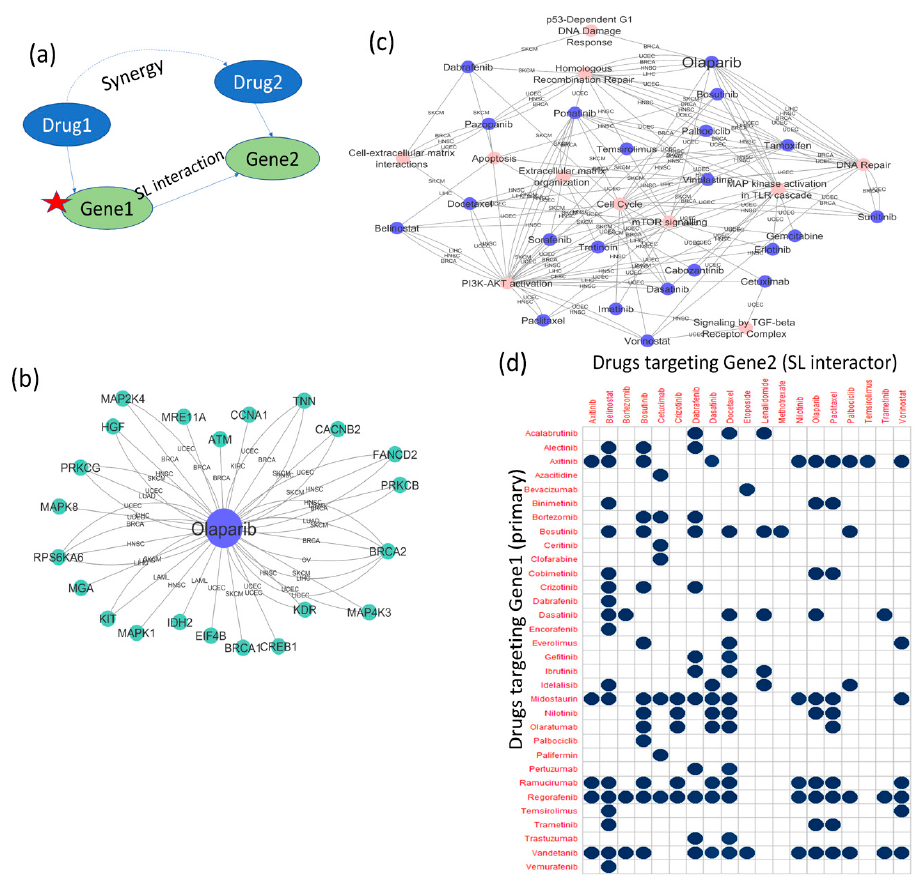
Figure 4. Mutations in cancer genes make cancer cells sensitive to certain drugs. ( a ) A schematic diagram showing the concept of potential synergy between drugs targeting synthetic lethal partners.